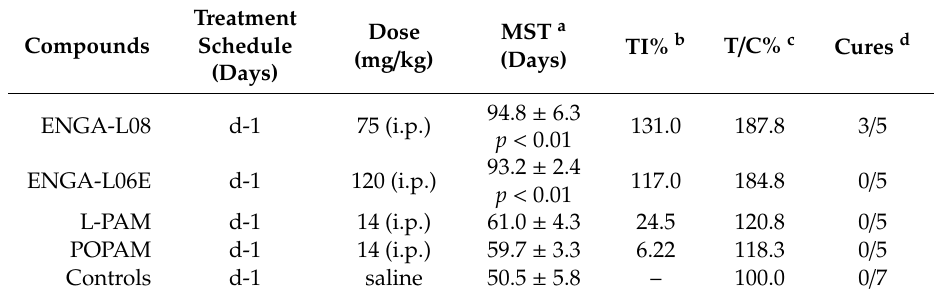
Table A4. In vivo antitumor e ff ects of compounds ENGA-L06E, ENGA-L08E, L-PAM and POPAM on OVCAR-5 human ovarian adenocarcinoma xenograft bearing mice.